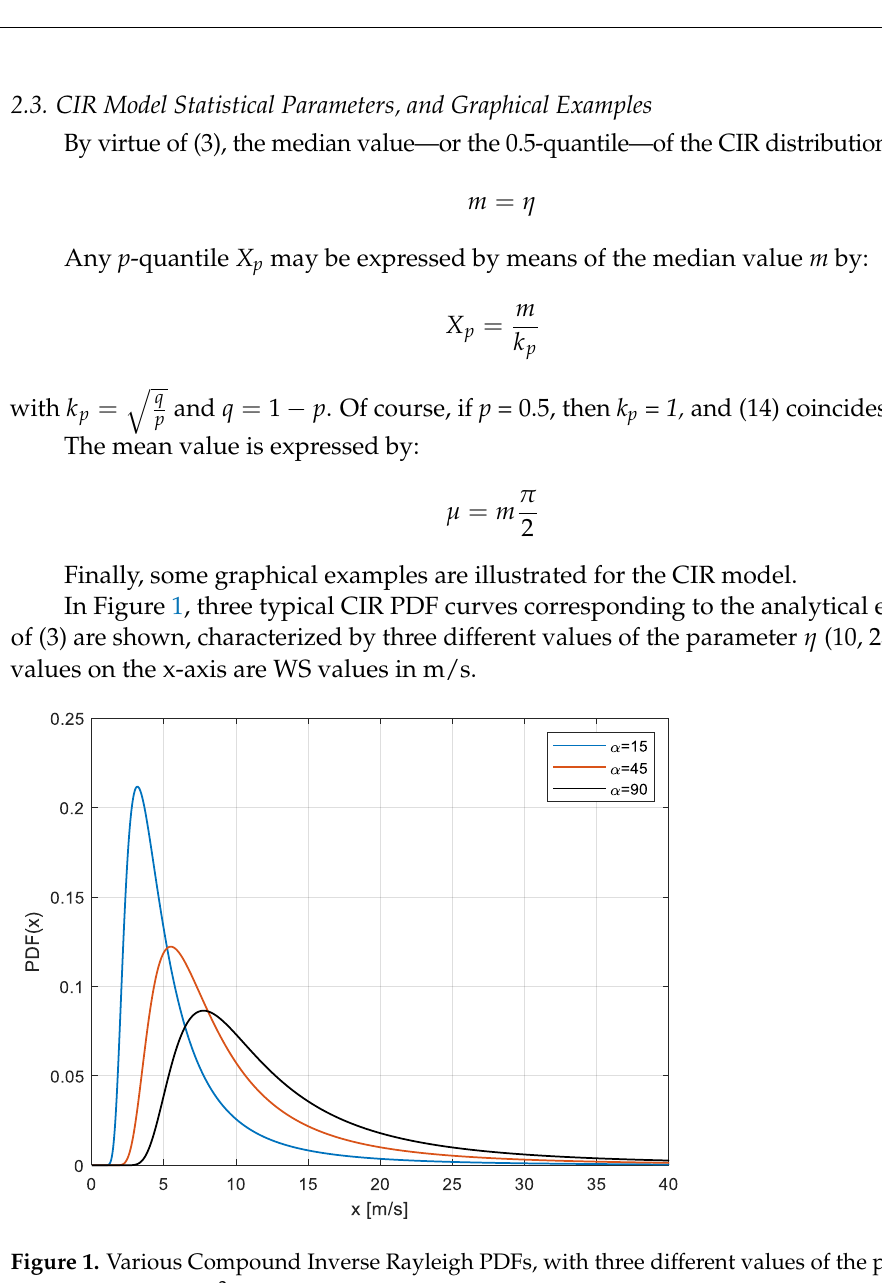
Figure 1. Various Compound Inverse Rayleigh PDFs, with three different values of the parameter η (the parameter α = η 2 appears in the legend) The values on the x -axis are WS values in m/s.